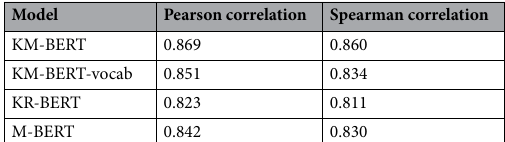
Table 3. Extrinsic evaluation results on MedSTS.